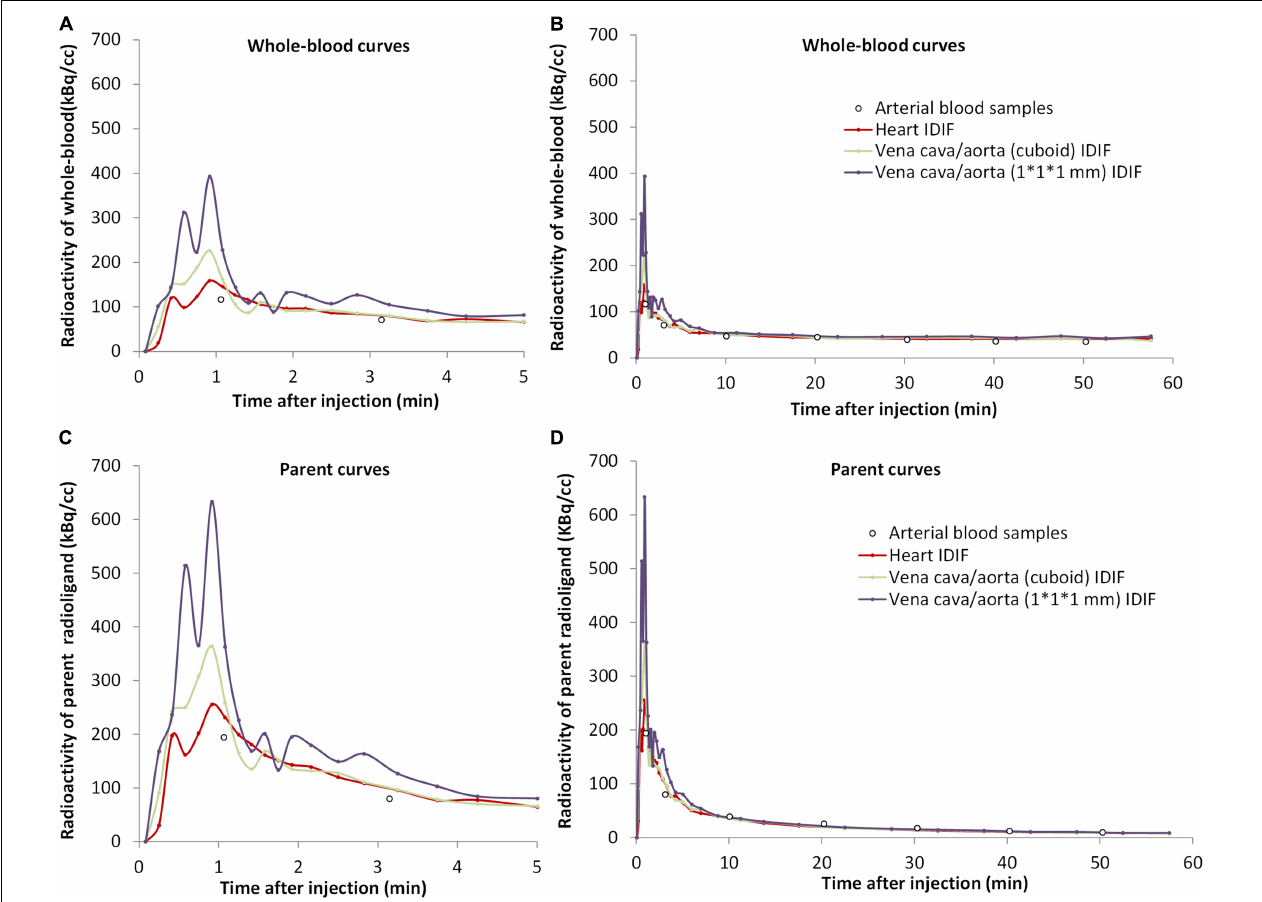
FIGURE 2 | The concentrations over time of [ 18 F]CPFPX in whole-blood (A,B) and parent radioligand (C,D) (with metabolite correction) curves from the arterial input function (white dots) and from the three image-derived input functions (IDIFs) with different volumes of interest (VOIs) (colored lines) in a representative animal. The left curves (A,C) are excerpts of the first 5 min of the total curves (B,D) .